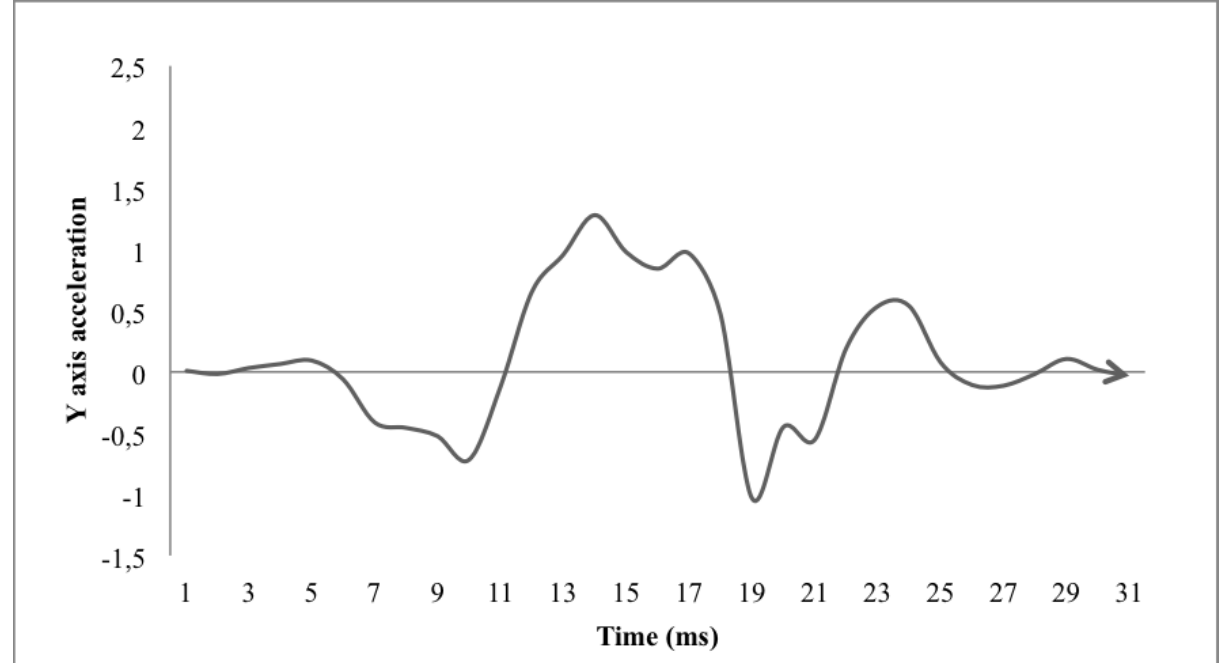
Figure 1. SJ Y axis acceleration graphic